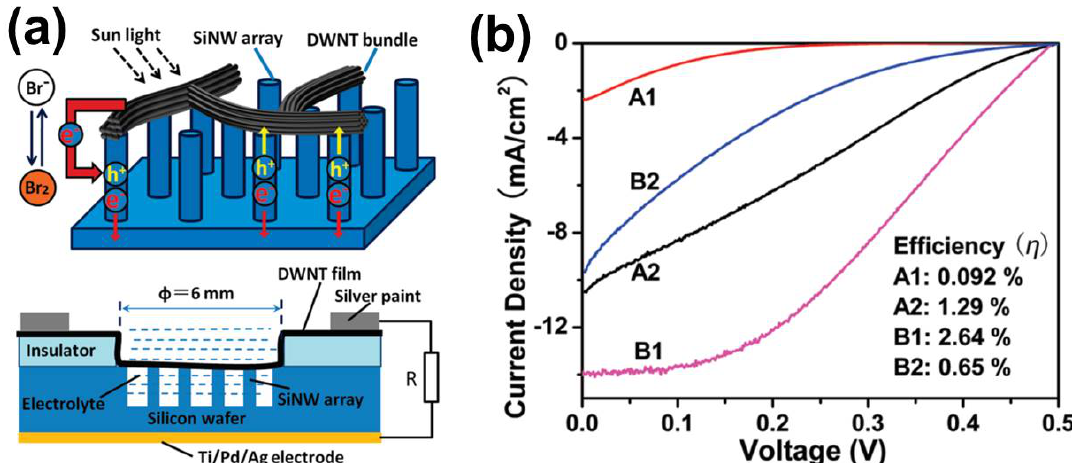
Figure 14. ( a ) Schematics and side view of a hybrid heterojunction/photoelectrochemical cell (PEC) solar cell fabricated with silicon nanowire (SiNW) arrays and DWNT films. Reproduced with permission from [188], Copyright American Chemical Society, 2009. ( b ) The current density is plotted against voltage for several samples prepared in different ways: Sample A1 (SiNW/DWNT heterojunction without redox electrolyte), Sample A2 (SiNW/DWNT heterojunction with redox electrolyte), Sample B1 (Si wafer/DWNT heterojunction without redox electrolyte) and Sample B2 (Si wafer/DWNT heterojunction with redox electrolyte). The inset brings the efficiency obtained for each sample. The redox electrolyte improves the efficiency in SiNW/DWNT-based devices, but worsens the efficiency in Si wafer/DWNT-based devices. Reproduced with permission from [188], Copyright American Chemical Society,